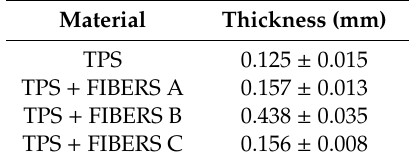
Figure 3 . ( a ) Fibers as received after cleaning; ( b ) fibers after mashing in ball mill . Table 1. Thickness of thermoplastic starch (TPS) and TPS–dry nopal fiber composites.